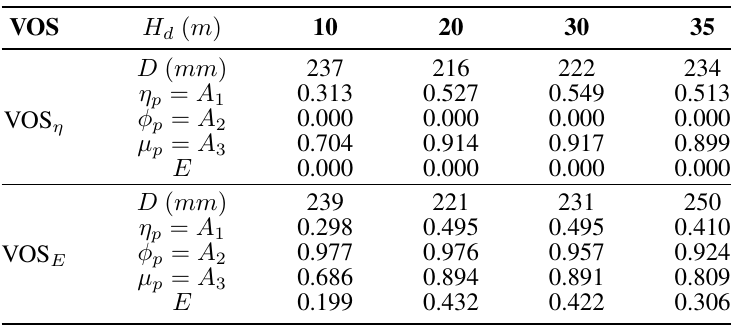
Table 3. VOS results in electric regulation (ER)